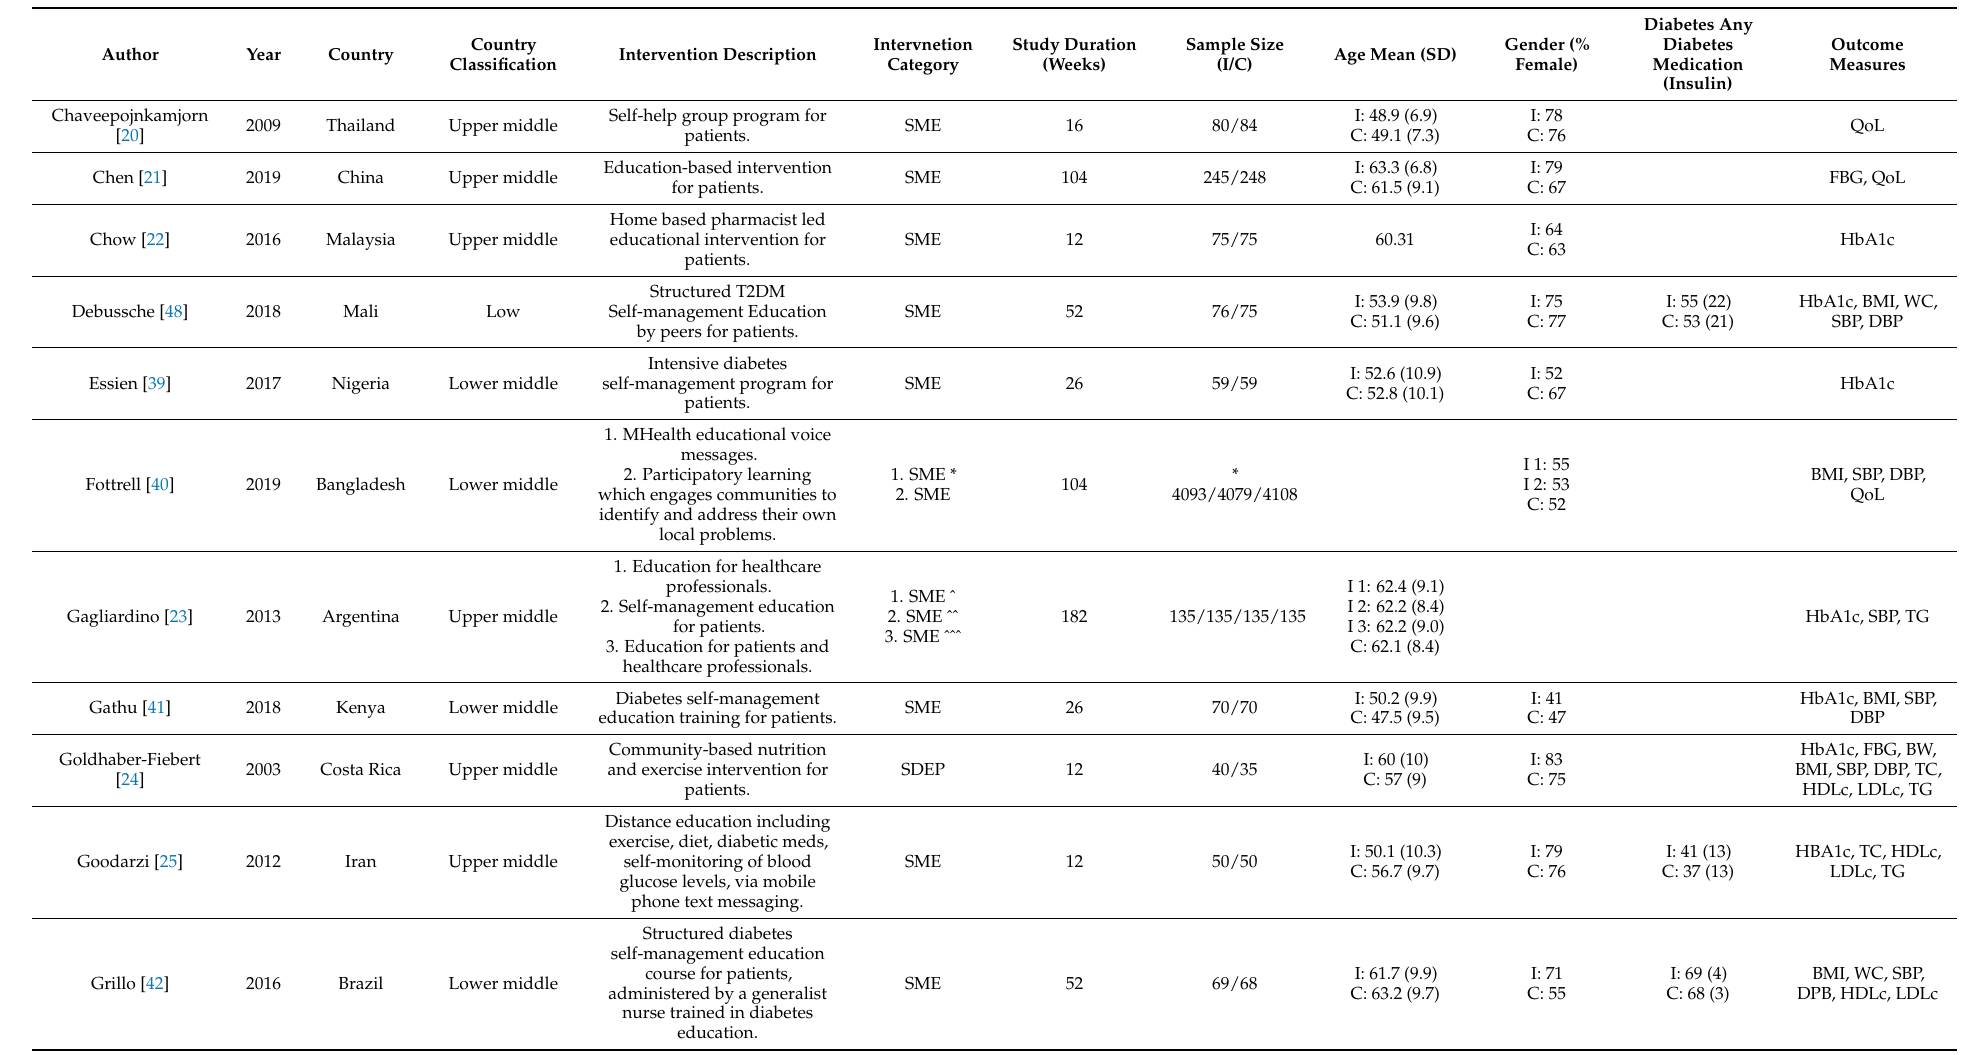
Table 1. Characteristics of studies included in the